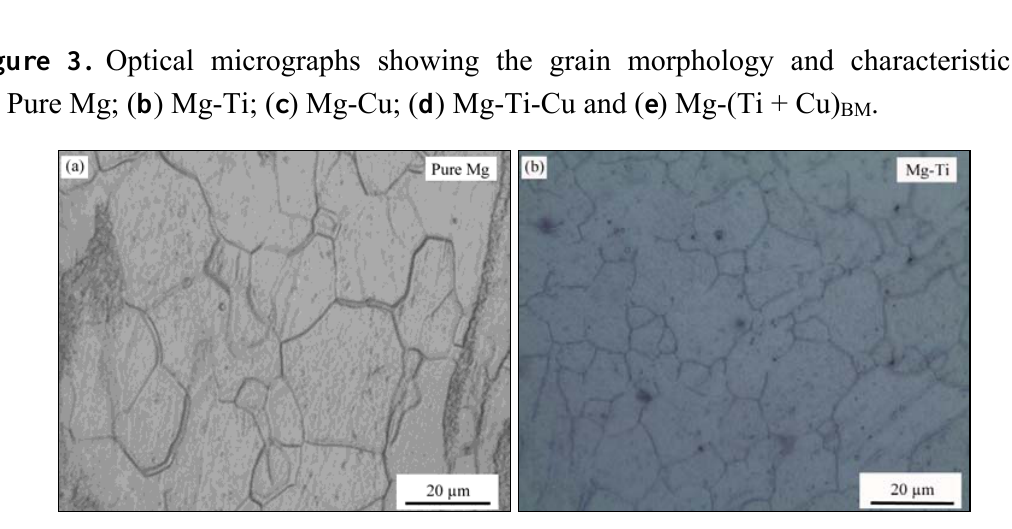
Figure 3. Optical micrographs showing the grain morphology and characteristics of ( a ) Pure Mg; ( b ) Mg-Ti; ( c ) Mg-Cu; ( d ) Mg-Ti-Cu and ( e ) Mg-(Ti + Cu)